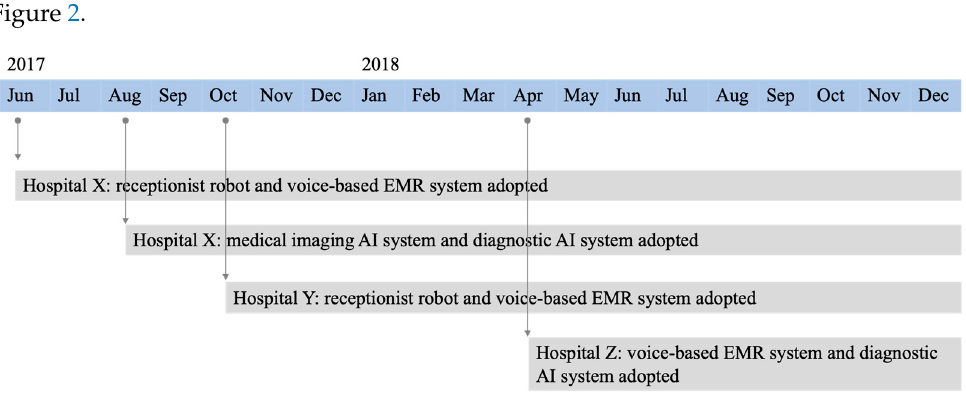
Figure 2. Timeline of medical artificial intelligence (AI) systems adopted in the three cases.